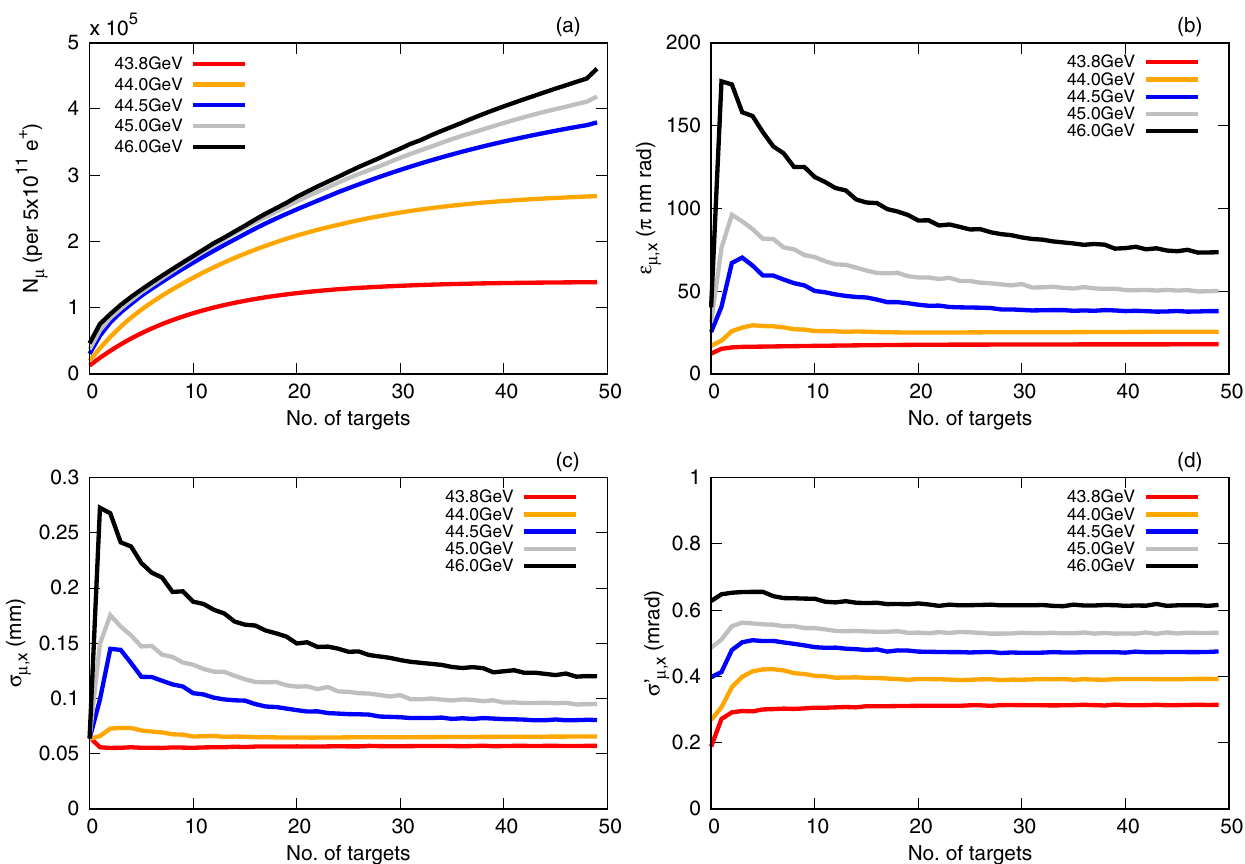
FIG. 6. (a) Muon bunch population N μ , (b) horizontal emittance ϵ μ ;x , (c) beam size σ μ ;x and (d) divergence σ 0 μ ;x from the simulation of a 5 × 10 11 e þ bunch impinging on 50 targets of 1% X 0 each (equivalent to 3.5 mm of Beryllium material) for five different positron beam energies. The transport line k 1 coefficients have been kept constant while changing the positron beam energy, therefore, the lattice is always matched but the equivalent gradients change slightly.